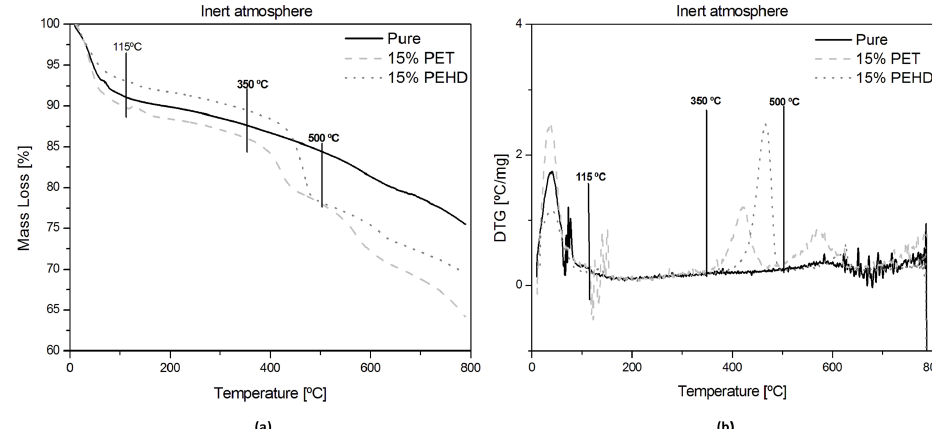
Figure 2. TG and DTG curves of samples in an inert atmosphere.